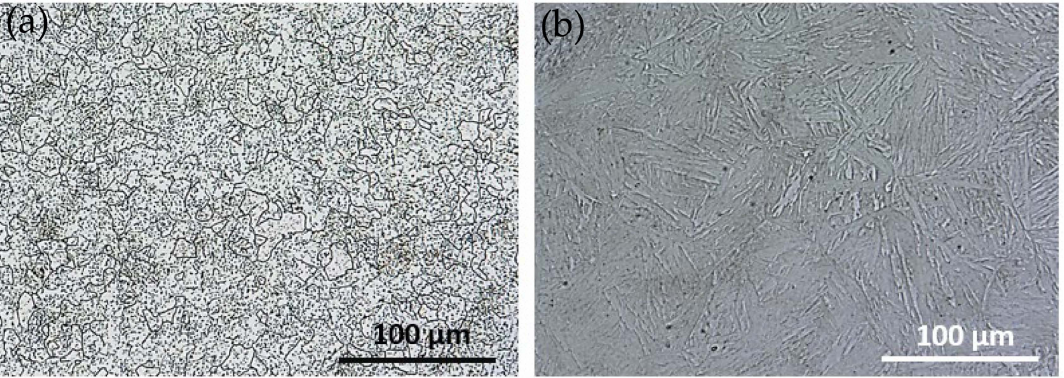
Figure 3. Image of X37CrMoV5-1 in ( a ) as-delivered state, ( b ) after DSC testing made by using a digital